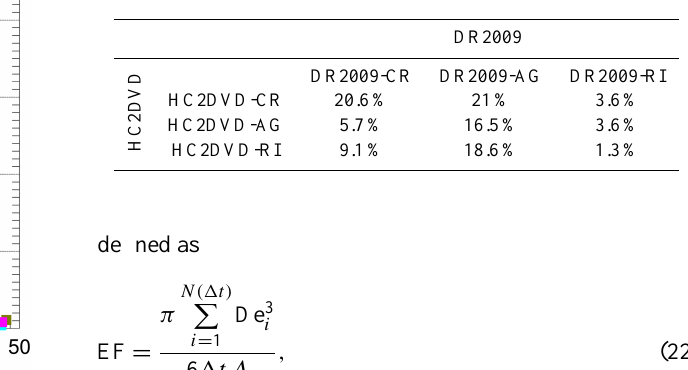
Table 7. As in Table 6 but showing the comparison between HC2DVD and DR2009. The comparison is conducted on three hy- drometeor classes: crystal (CR), aggregates (AG), and rimed-ice particles (RI). The overall accuracy of the comparison is 38%, and Cohen’s kappa is